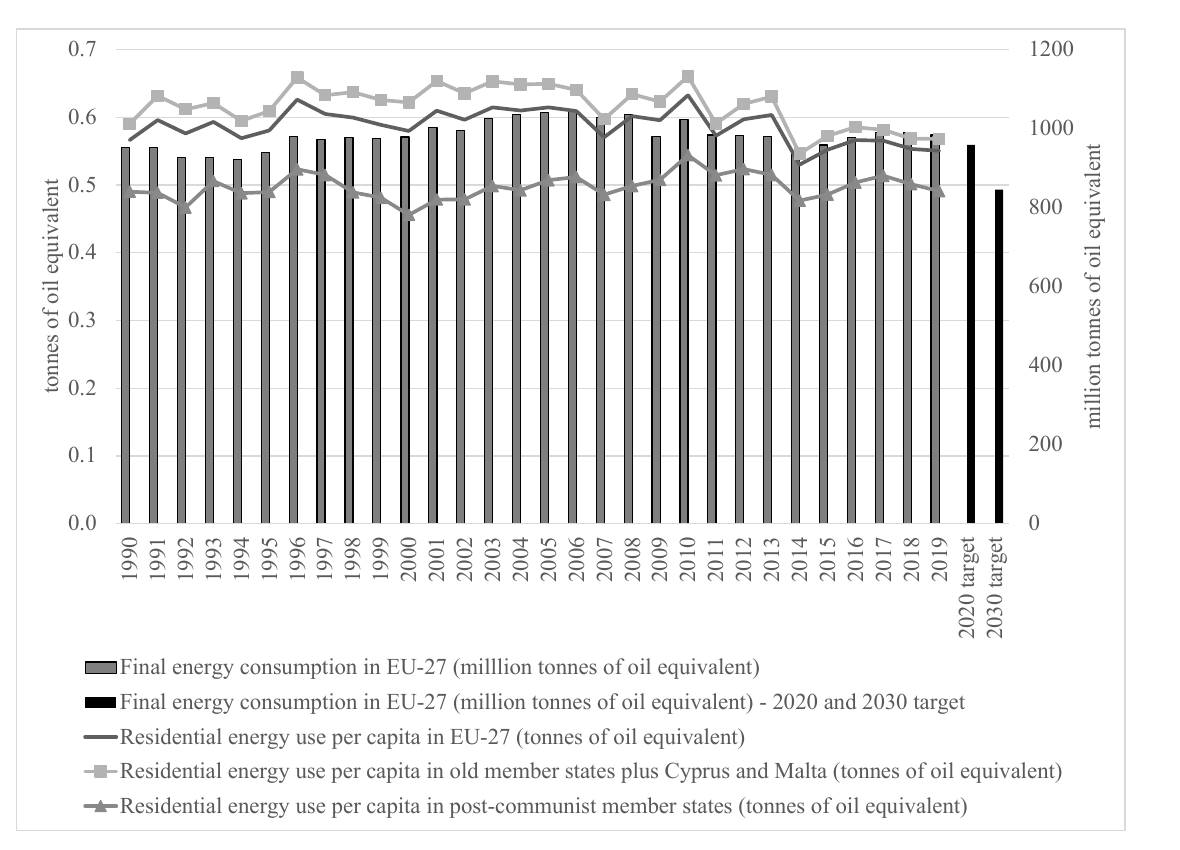
Figure 1. Residential energy use per capita (toe), final energy consumption (Mtoe), and energy efficiency targets (2020 and 2030, Mtoe) in the European Union (1990–2019).